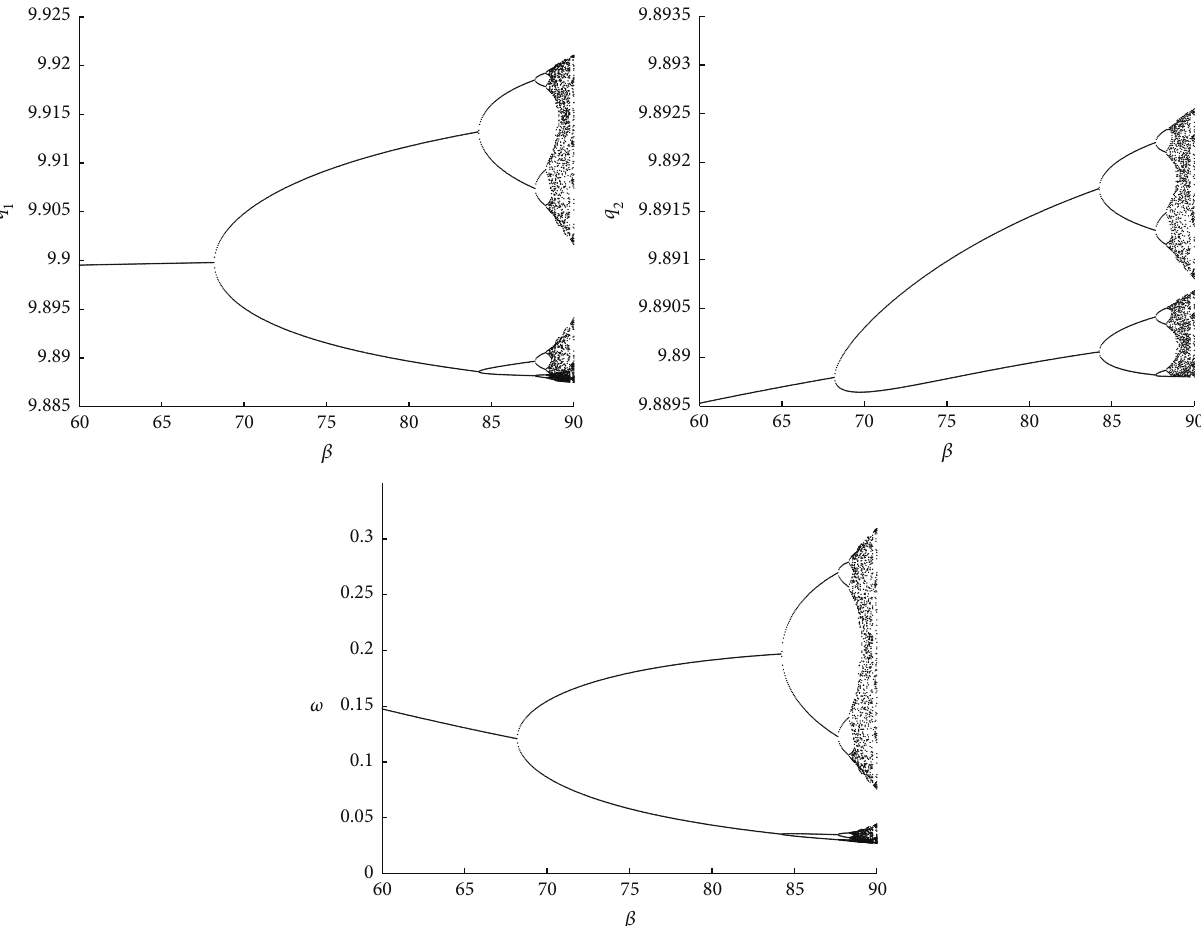
Figure 7: Bifurcation diagrams of quantities 𝑞 1 and 𝑞 2 and fraction 𝜔 with respect to the evolutionary pressure 𝛽 . Increasing 𝛽 has a destabilizing effect for 𝑐 2 slightly larger than 𝑐 1